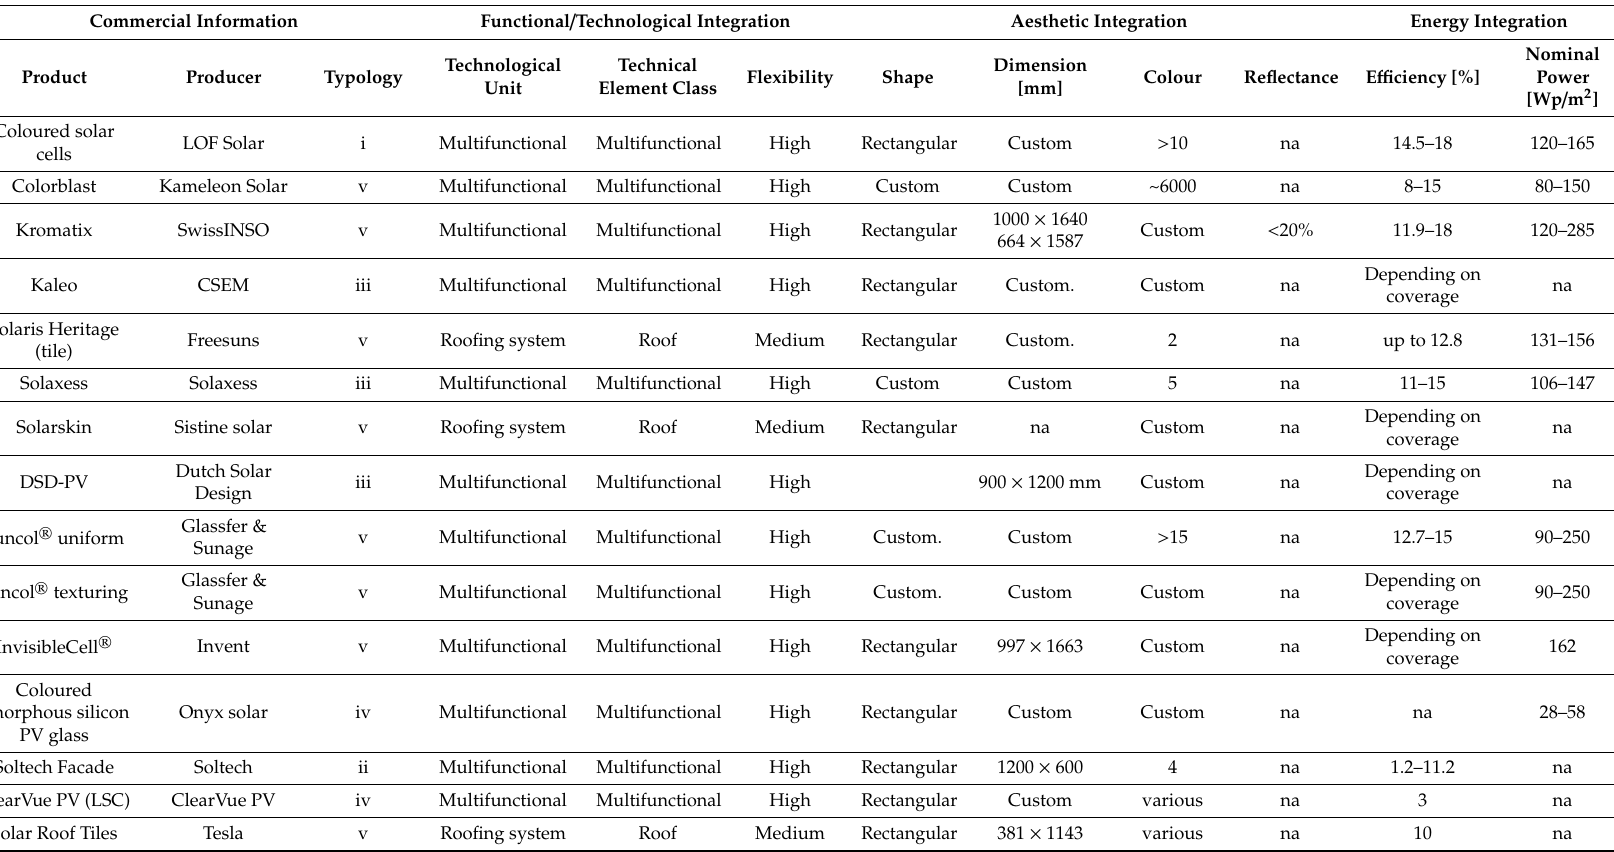
Table 1. Commercially available BIPV products, divided by typology: (i) solar cells with anti-reflection coating; (ii) semi-transparent or coloured PV-active layers; (iii) layers or interlayers containing solar filters, coloured or patterned coatings; (iv) coloured polymeric encapsulant films; and (v) printed, coated or alternative finished front